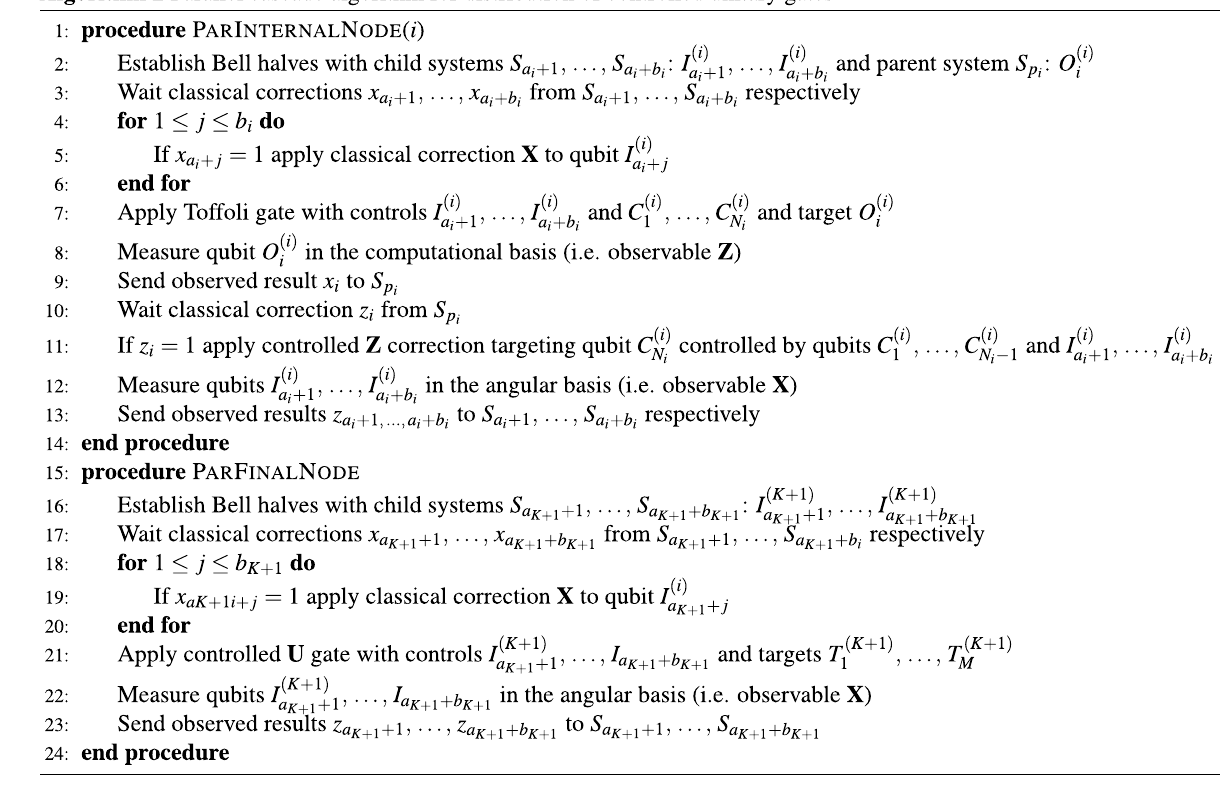
Existing Algorithms 8,9,12 (Fig. 1) 2 N N Sequential Cascade (Fig. 4) 2 N max Binary Parallel Cascades (Fig. 3) 2 N O √ N Parallel Cascades (Fig. 3) 2 Table 1. Comparison of distribution protocols for a fully non-locally N -controlled unitary.